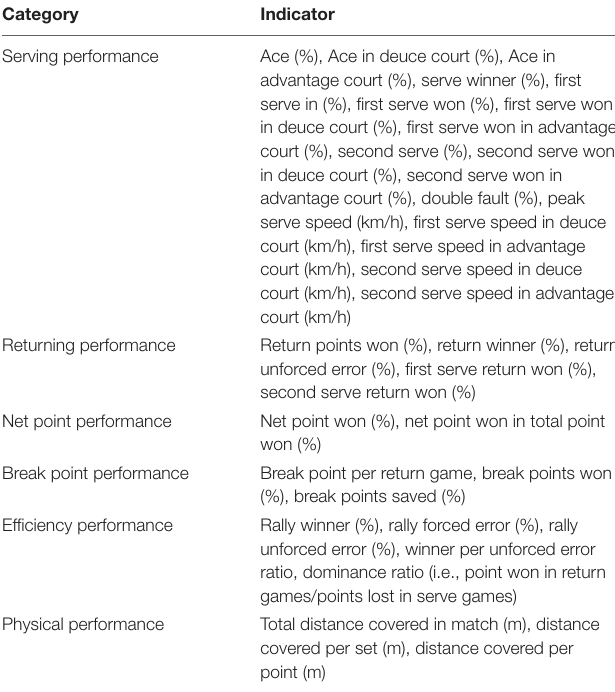
TABLE 2 | List of performance